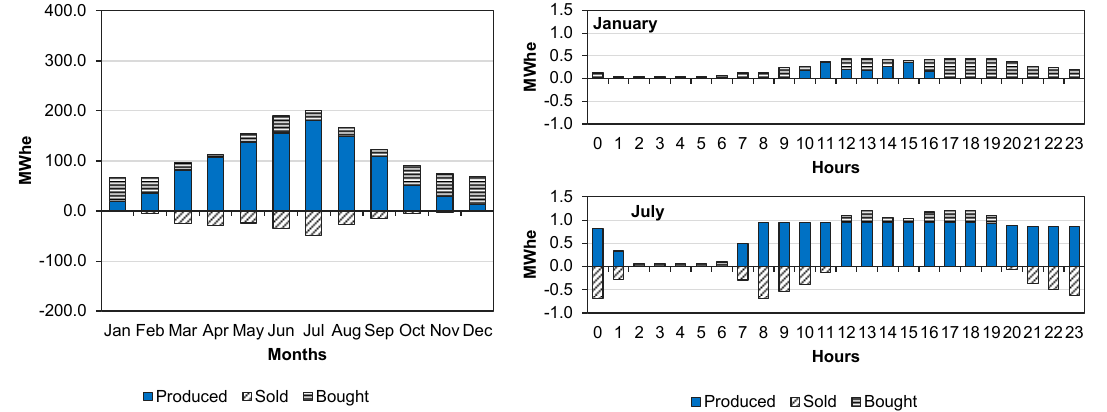
Figure 16. System B. Electricity produced, bought and sold in working days. Monthly values (left side) and hourly values (right side).